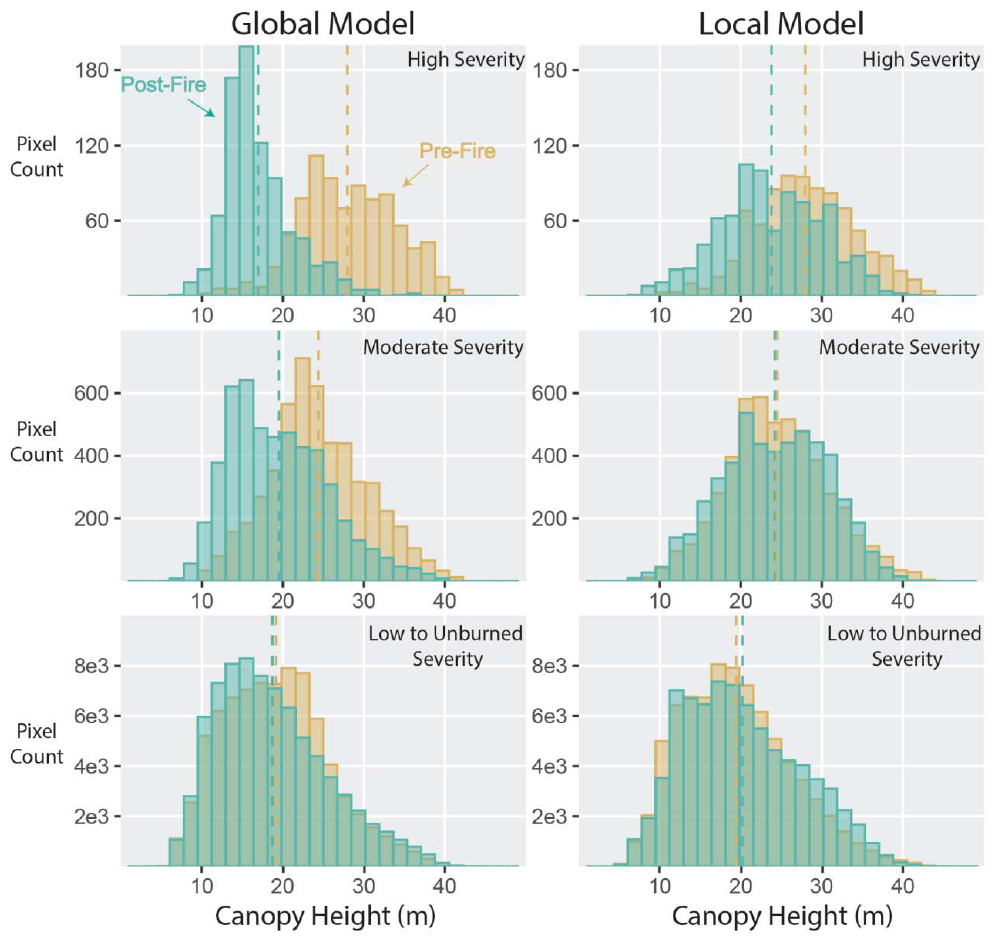
Figure 11. Comparison of pre- and post-fire, global and local (Ochoco) model predictions for canopy height in high ( top row ), moderate ( middle row ), and low to unburned ( bottom row ) fire severity classes for the Corner Creek Fire. Vertical dotted lines depict the mean prediction value.